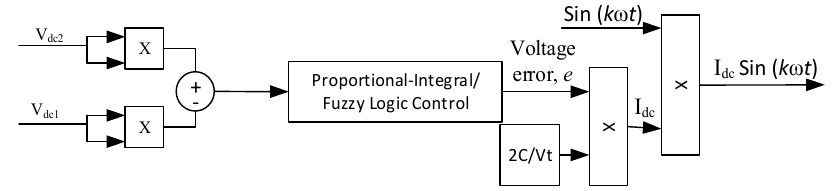
Figure 4. Direct control in self-charging algorithm.